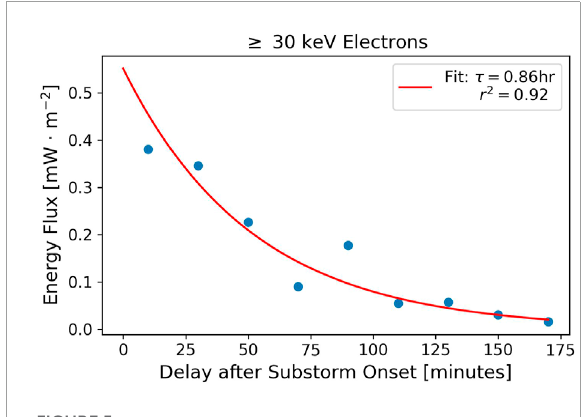
FIGURE 5 The decay rate of the differential energy flux from electrons with energies ≥ 30 keV after a substorm